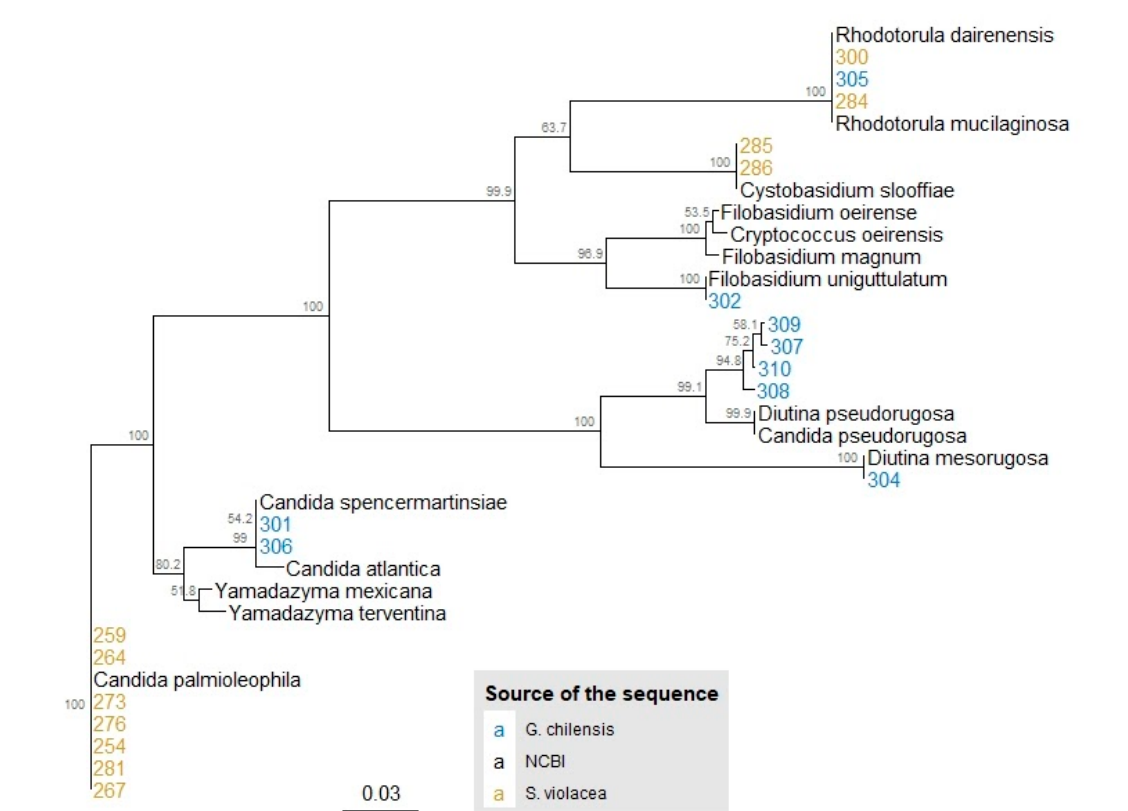
Figure 1. Phylogenetic tree of the 20 yeast isolated from Seriolella violacea and Genypterus chilensis. Phylogeny inferred with the Neighbor-Joining method and Kimura-2-parameters with 1000 bootstrap. Colored numbers represent the ID for one particular isolate. Isolates ID depicted in yellow were extracted from S. violacea, and those from G. chilensis are shown in blue. Sequences downloaded from NCBI (the closest relatives to the isolates in the study) are depicted in black.